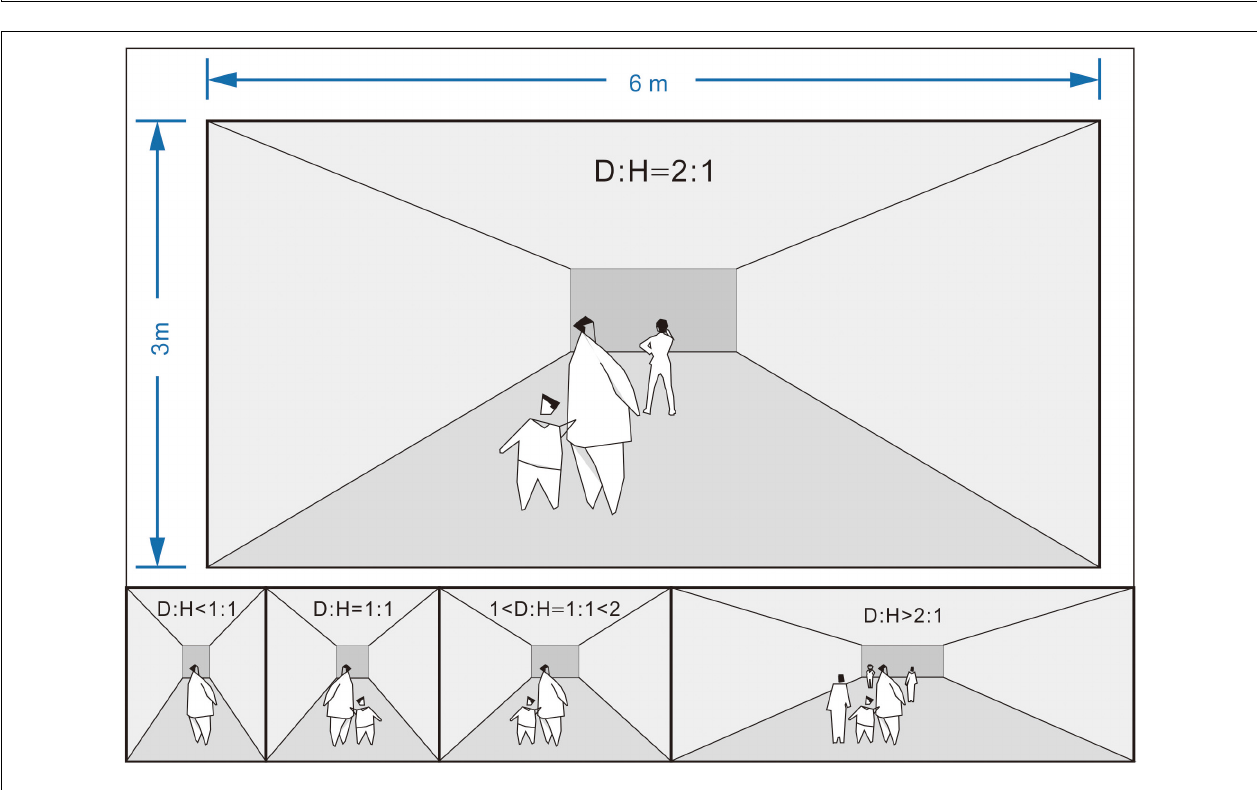
FIGURE 3 | Relatively comfortable proportions of the corridor width and height (cf., Ashihara, 1985; Park and Zhang,